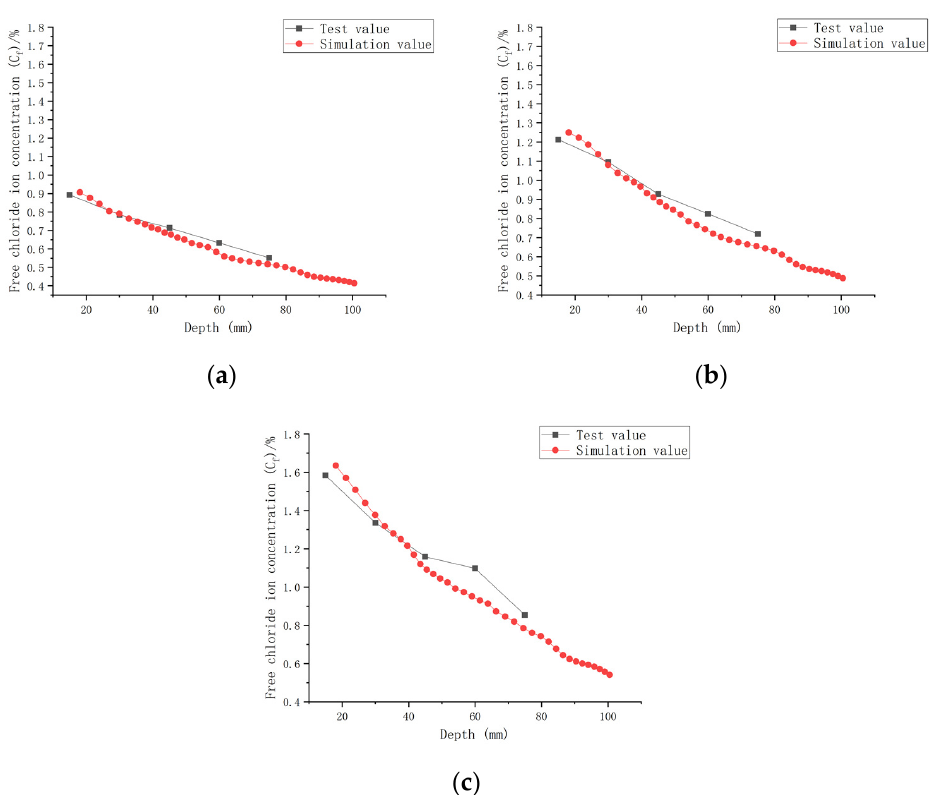
Figure 13. Relationship between C f and depth (W/C = 0.30). ( a ) Load is 0; ( b ) load is 0.1; ( c ) load is 0.2.